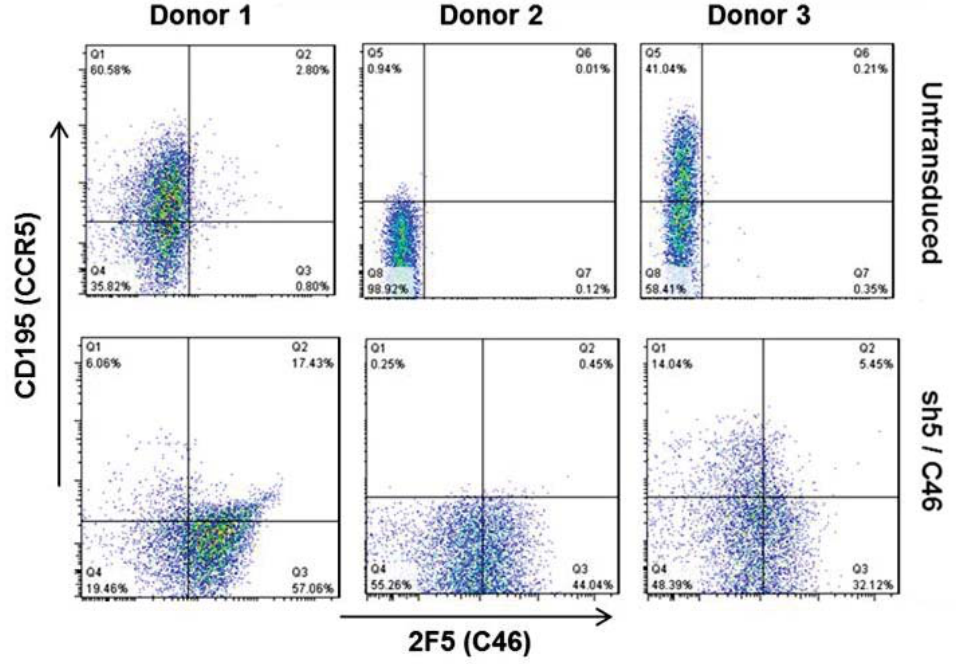
Figure 2. LVsh5/C46 introduction into target cells and simultaneous expression of C46 and knockdown of CCR5. Peripheral blood mononuclear cells (PBMC) were transduced with LVsh5/C46 (lower panel), or left untransduced (upper panel). C46 was detected by 2F5 monoclonal antibody, and CCR5 was detected by staining with anti-CD195 (CCR5) antibody. Cells from 3 independent donors are shown. Donor 2 was homozygous for CCR5-delta32 genotype and expresses no